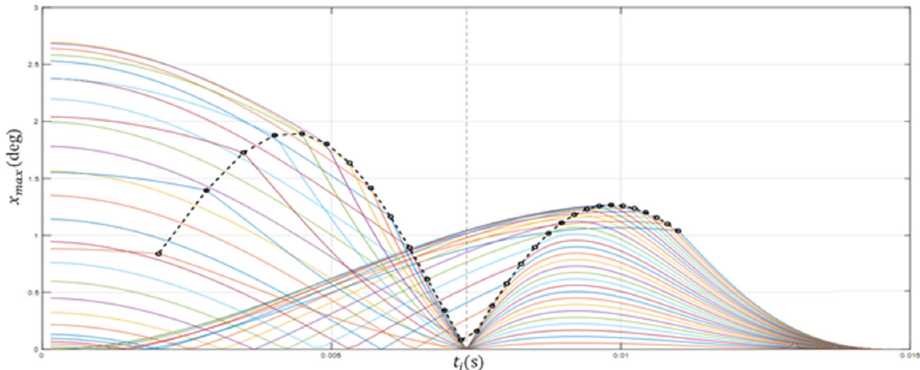
Figure 7. Representation of x max as function of t j for 1DoF system, fixing maximum acceleration and natural frequency.